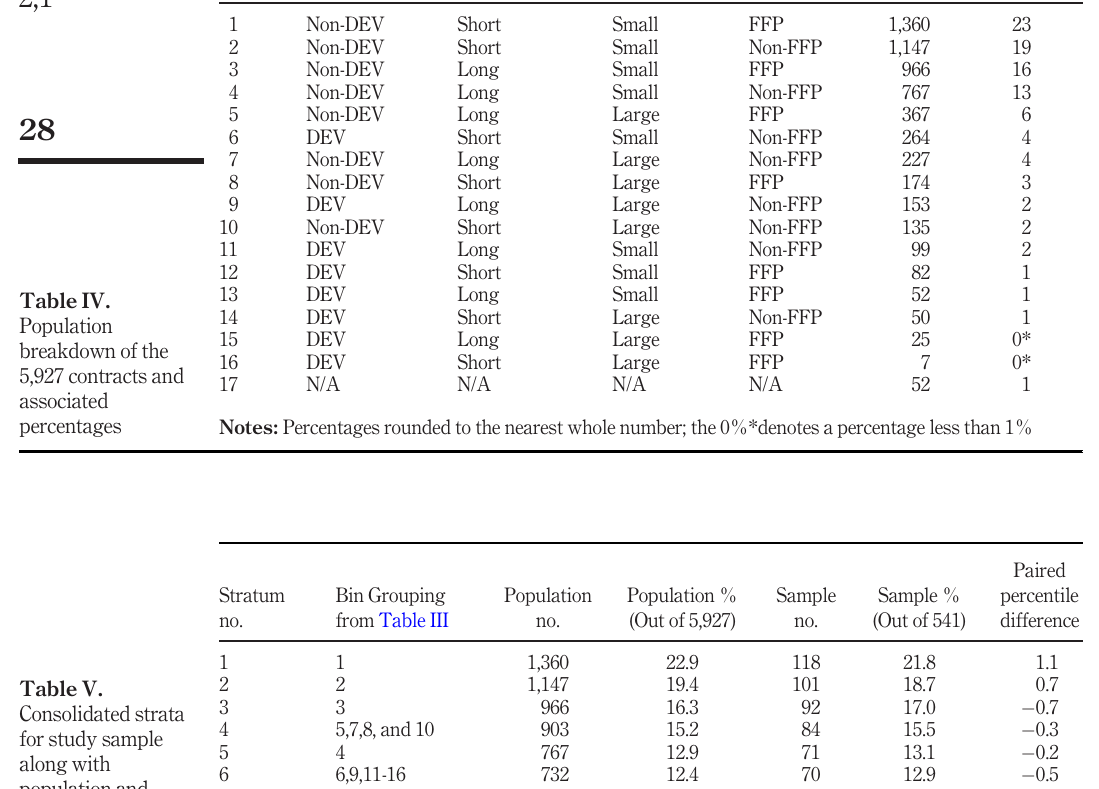
Table V. Consolidated strata for study sample along with population and matching sample characteristics